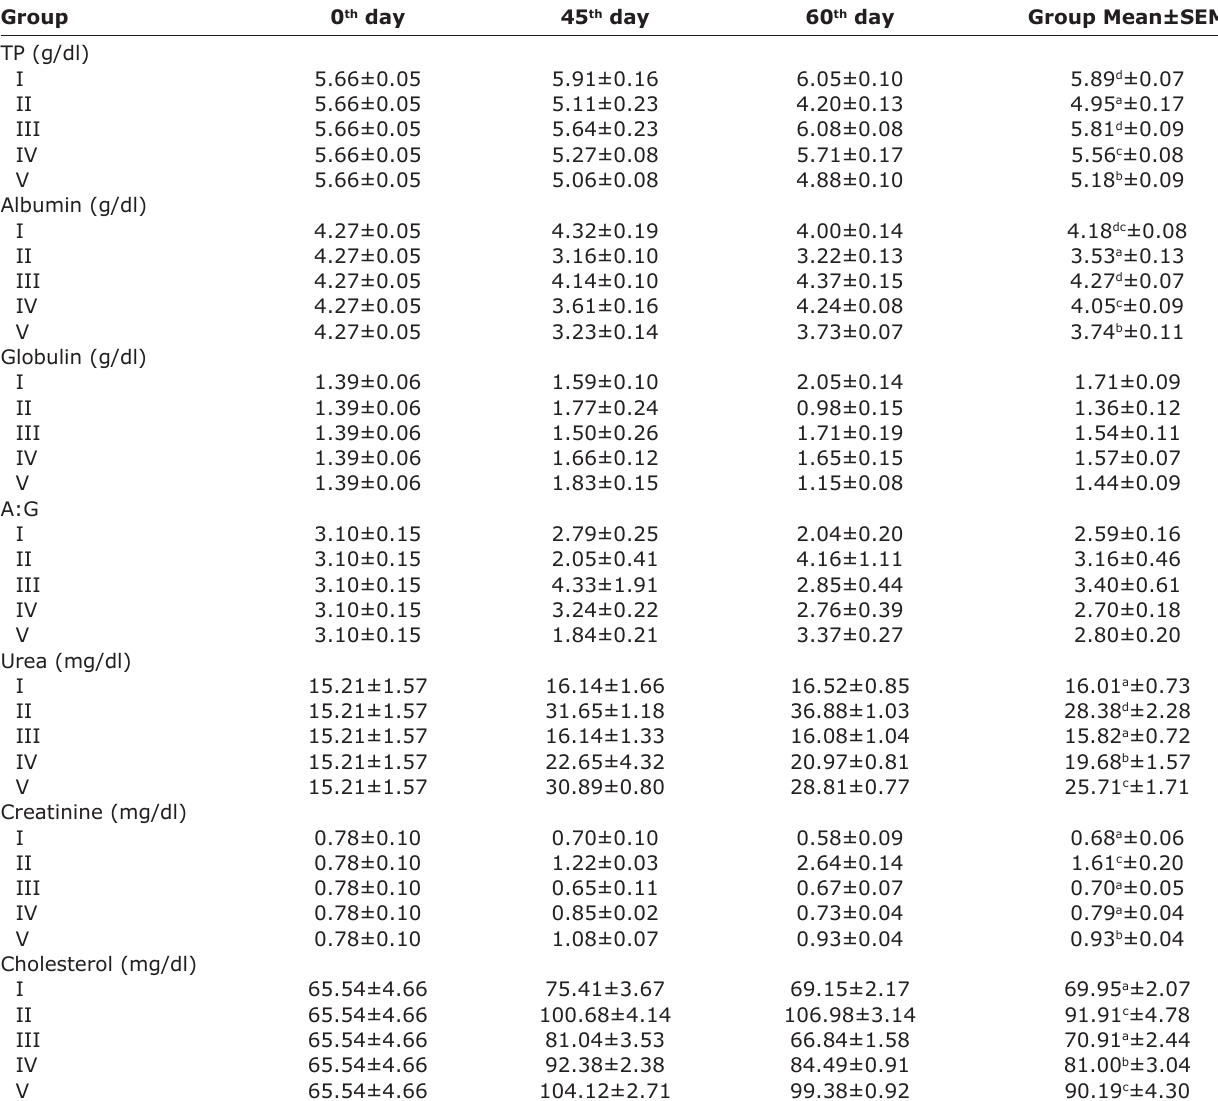
Table-2: Protective and ameliorative effects of SLE supplementation on biochemical parameters in lead intoxicated rats. Group 0 th